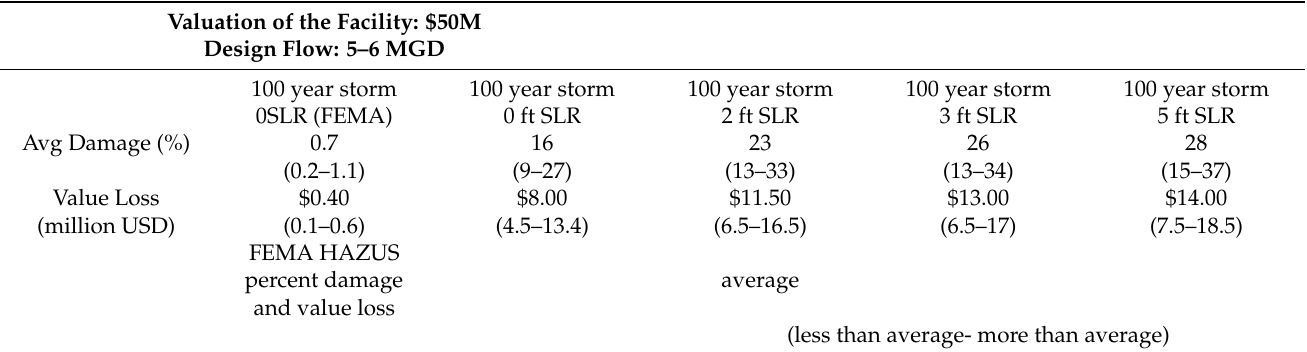
Table 3. Estimated average damage (%) and loss value ($ Million) vs. BFE (FEMA, SDE with